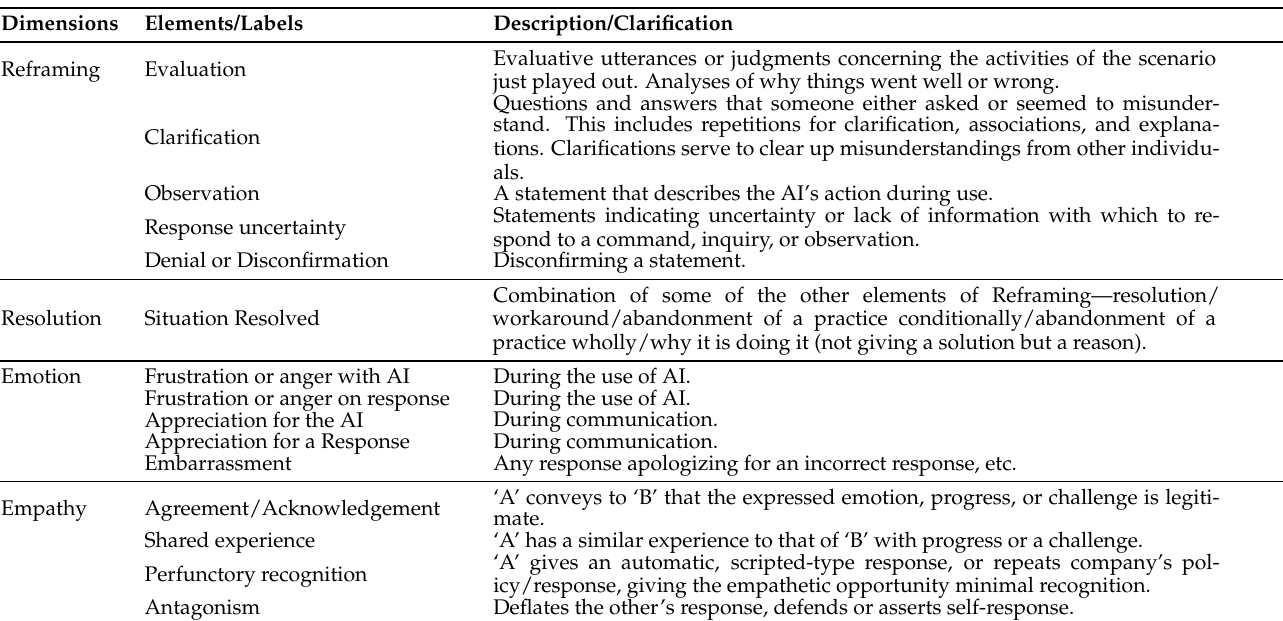
Table 2. Coding schemas for communication about AI